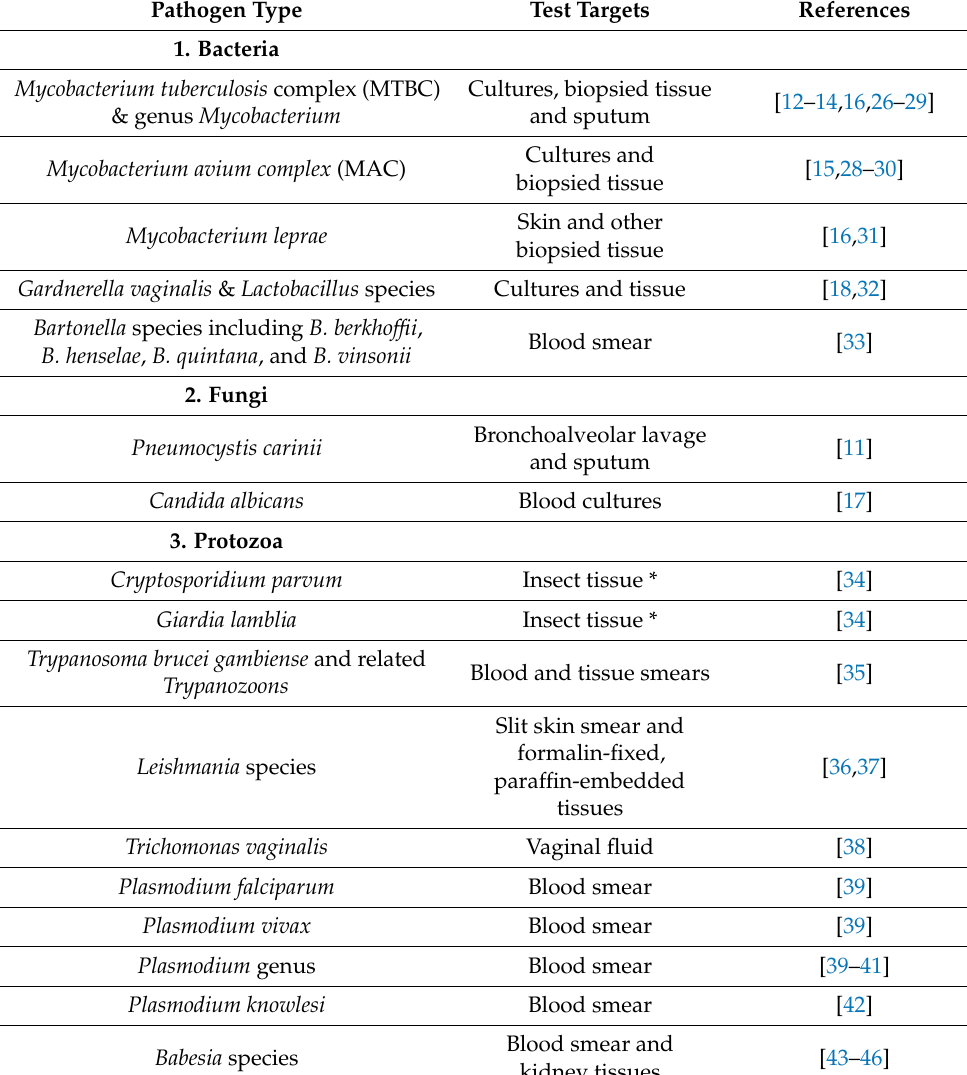
Table 1. FISH Tests for Identifying